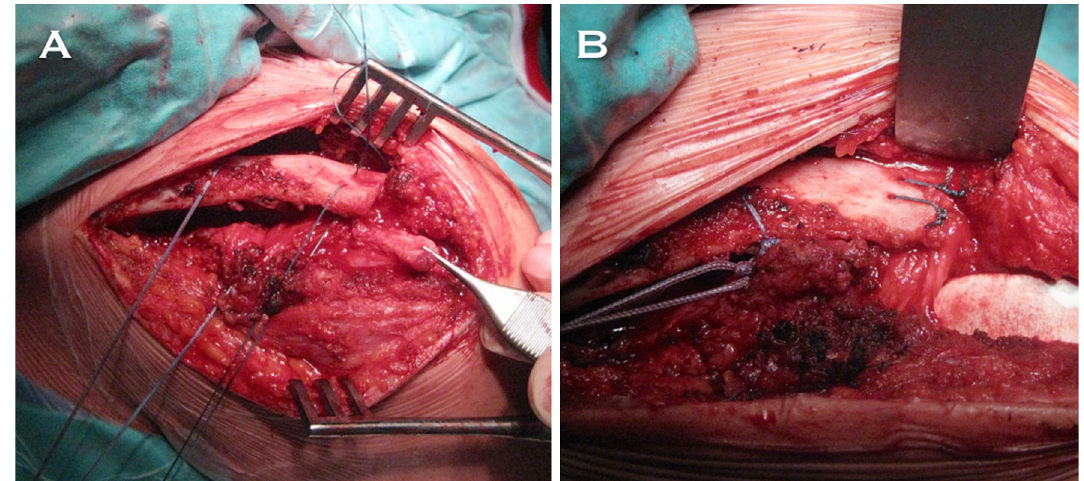
Fig. 1 Superolateral intraoperative perspective of a left shoulder with a history of chronic ACJ dislocation, that was managed by means of a modified Weaver–Dunn procedure. a Visualization of the coracoacro- mial (CA) ligament previous to its transfer to the distal third of the clavicle. Sutures have already been passed through the bone